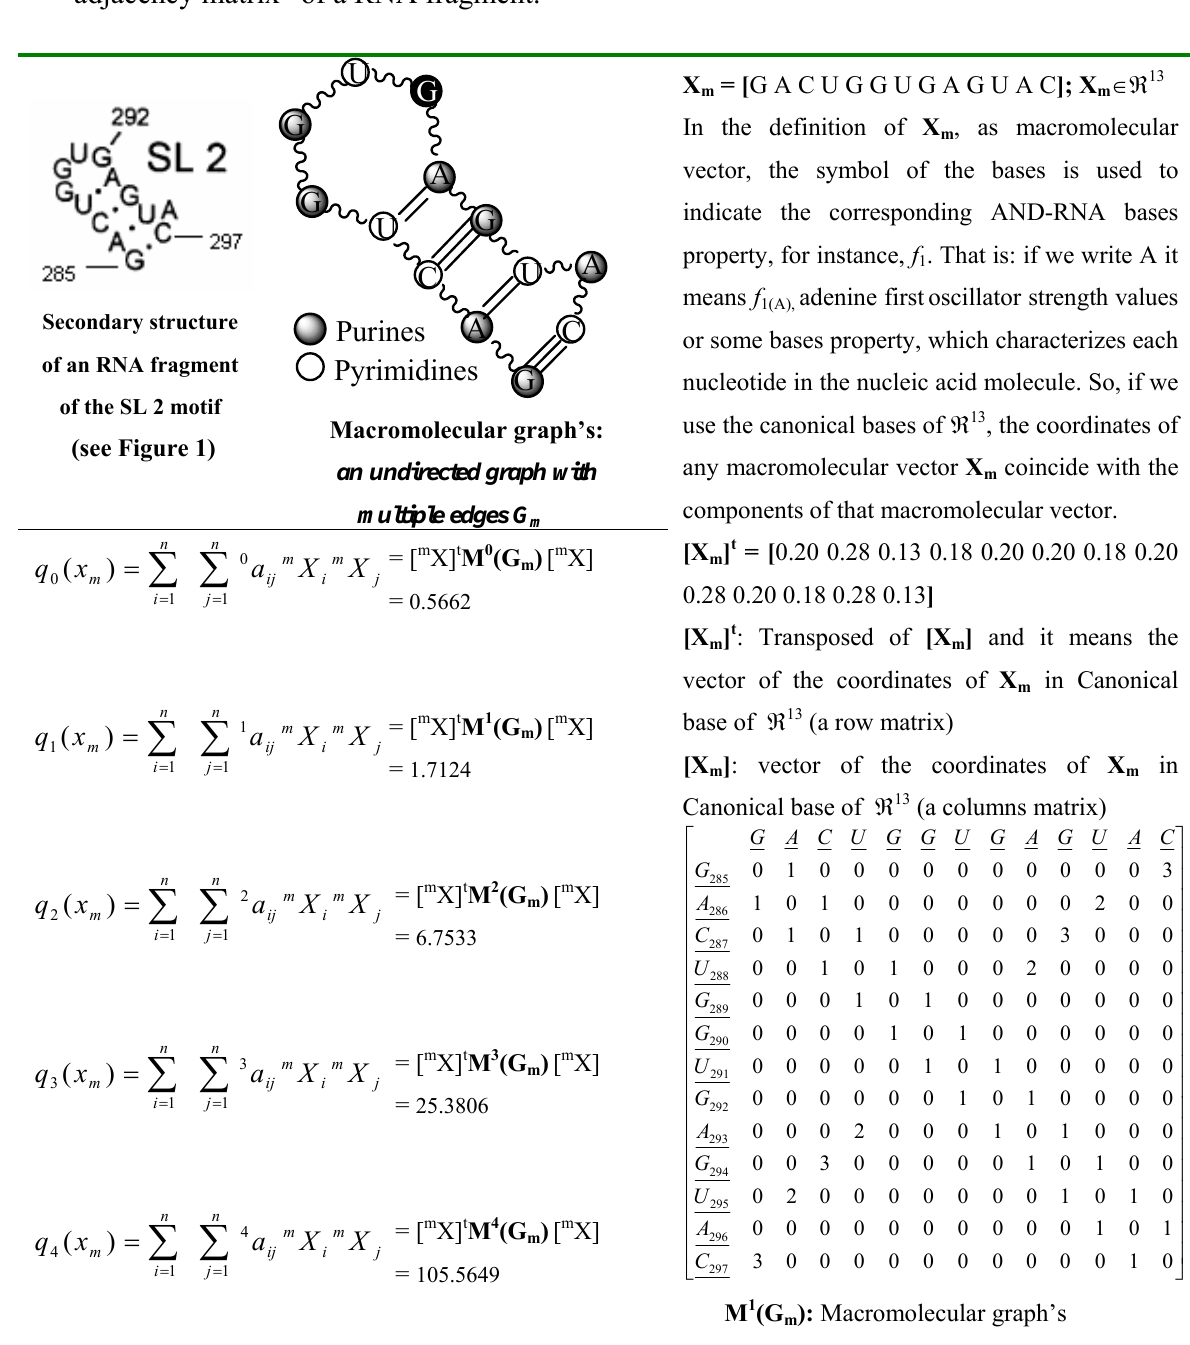
Table 2. A close up to the mathematical definition of total (RNA fragment) and local (nucleotide) nucleic acid quadratic indices of the “macromolecular graph’s nucleotide adjacency matrix” of a RNA